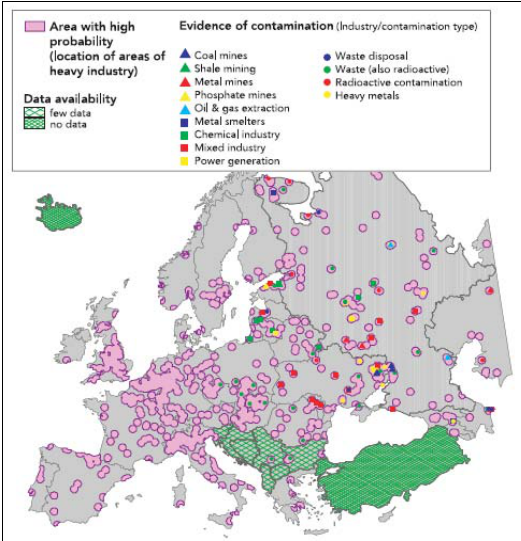
Fig 3. Probable problem areas of local contamination in Europe [2]